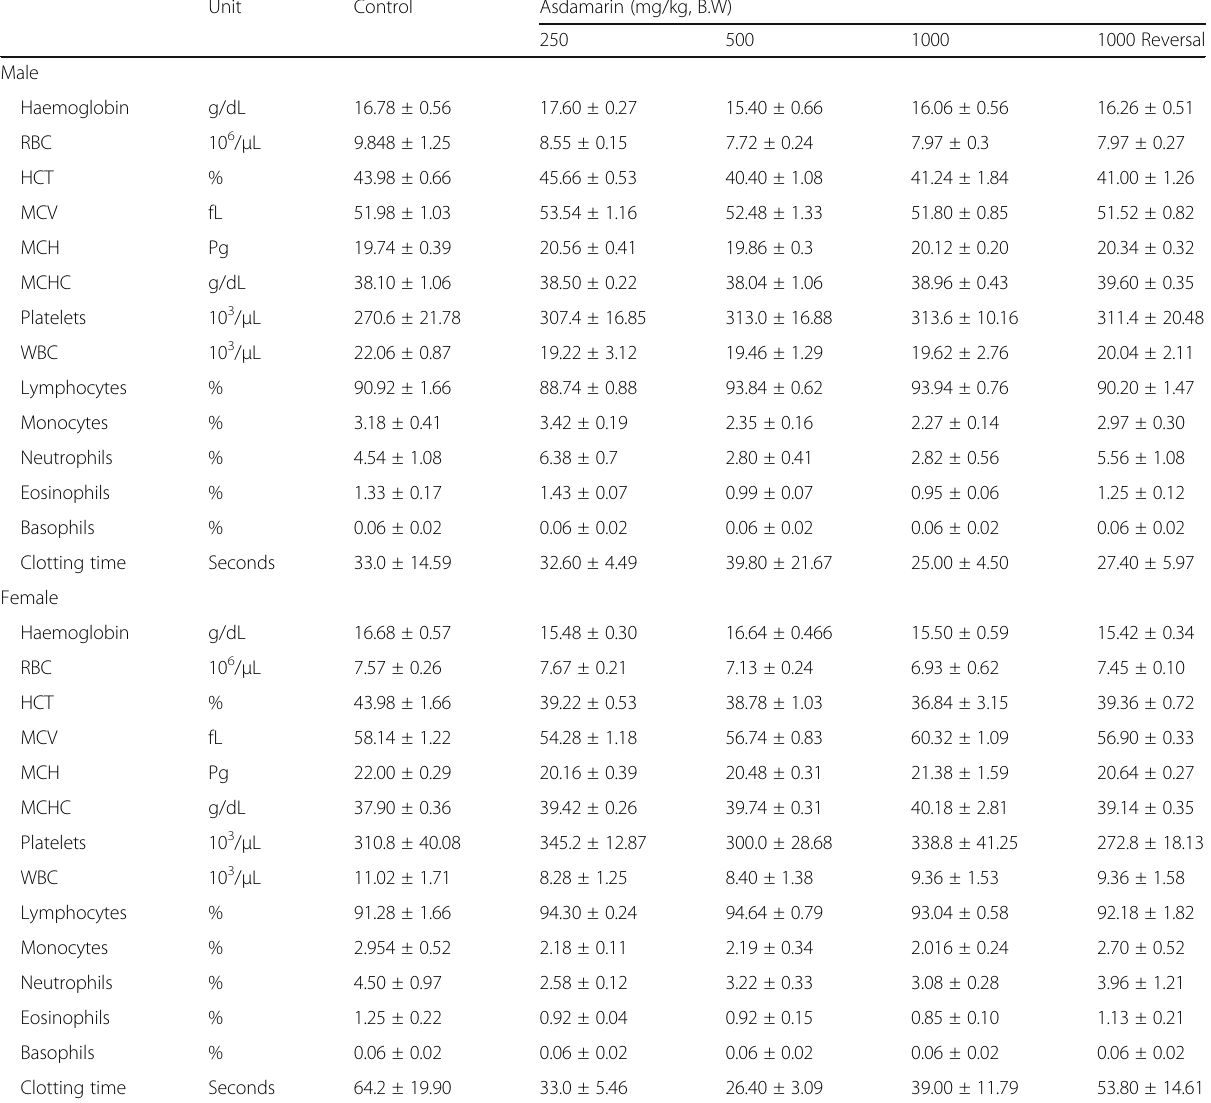
Table 4 Effect of Asdamarin on haematological parameters in rats Unit Control Asdamarin (mg/kg,